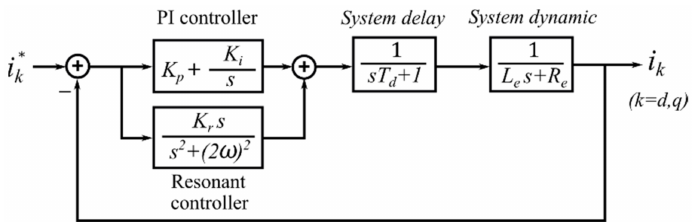
Figure 5. Block diagram of inner current control